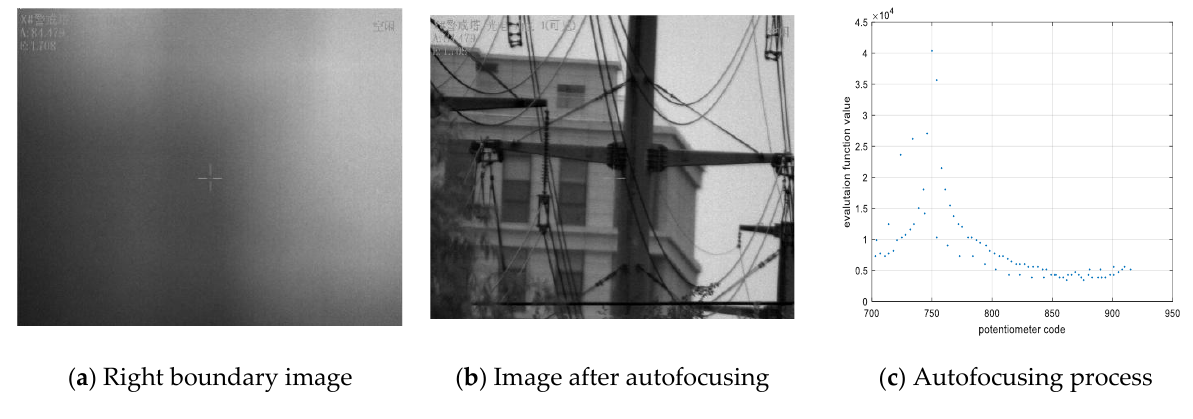
Figure 21. Right boundary autofocusing process.